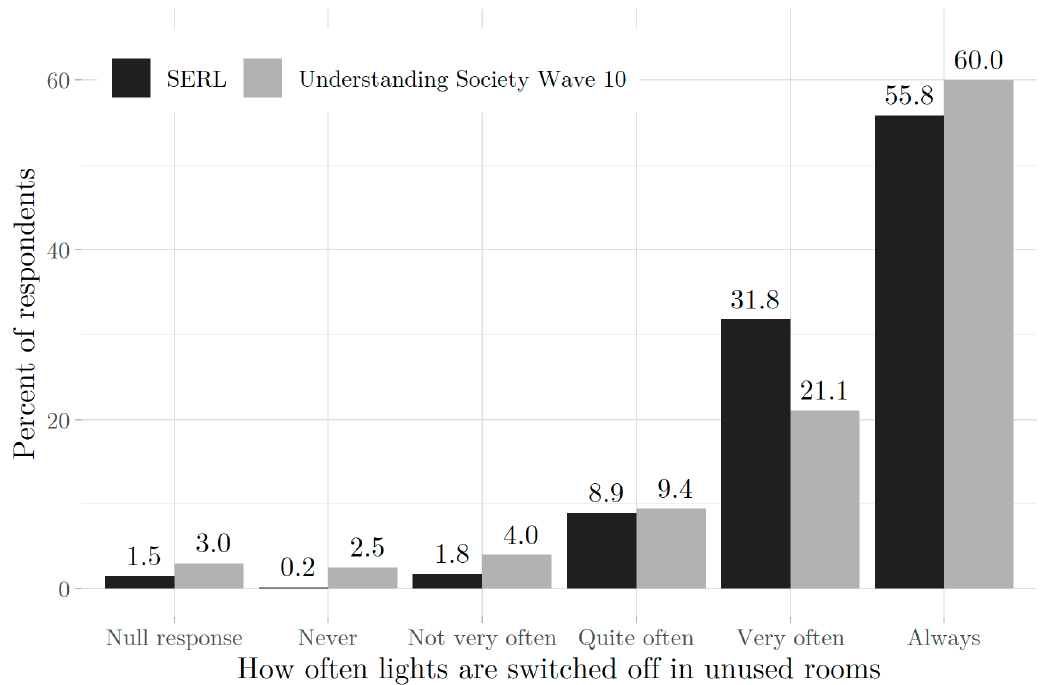
Figure 12. Responses given to question A13a about saving energy by switching off lights (SERL survey respondents compared to Understanding Society Wave 10).